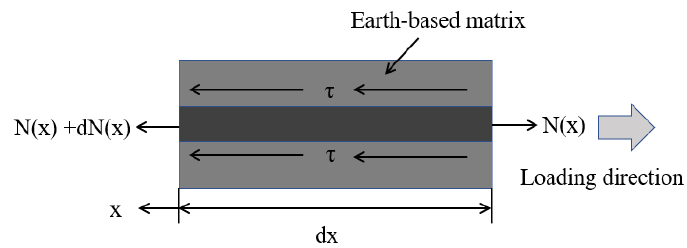
Figure 8. Static scheme of the interface during the pull-out test. Table 3. Characteristic values in bond-slip model.